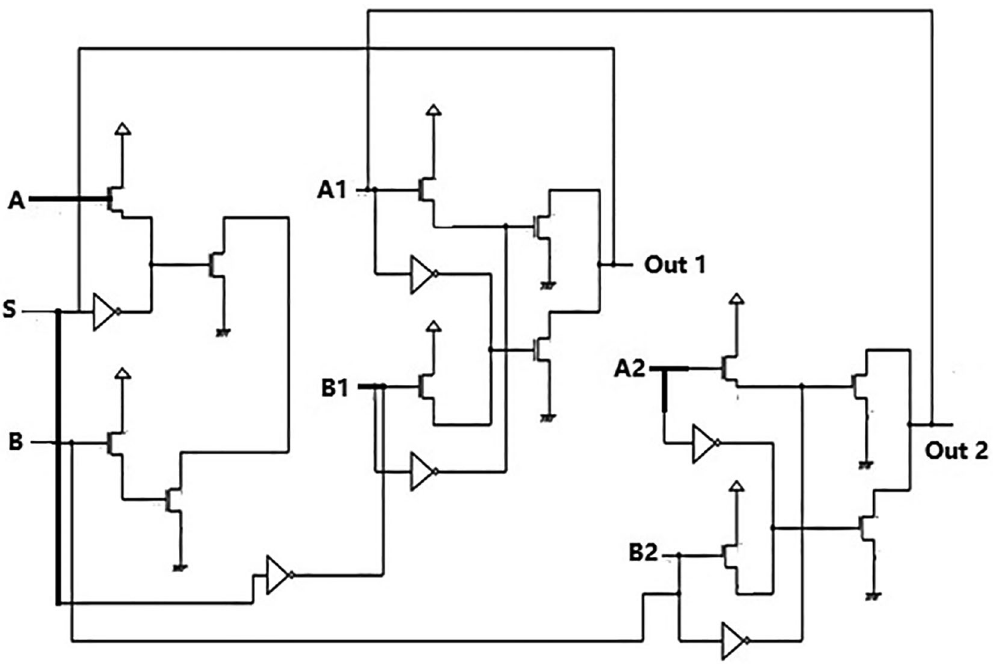
Figure 3. Proposed bit update